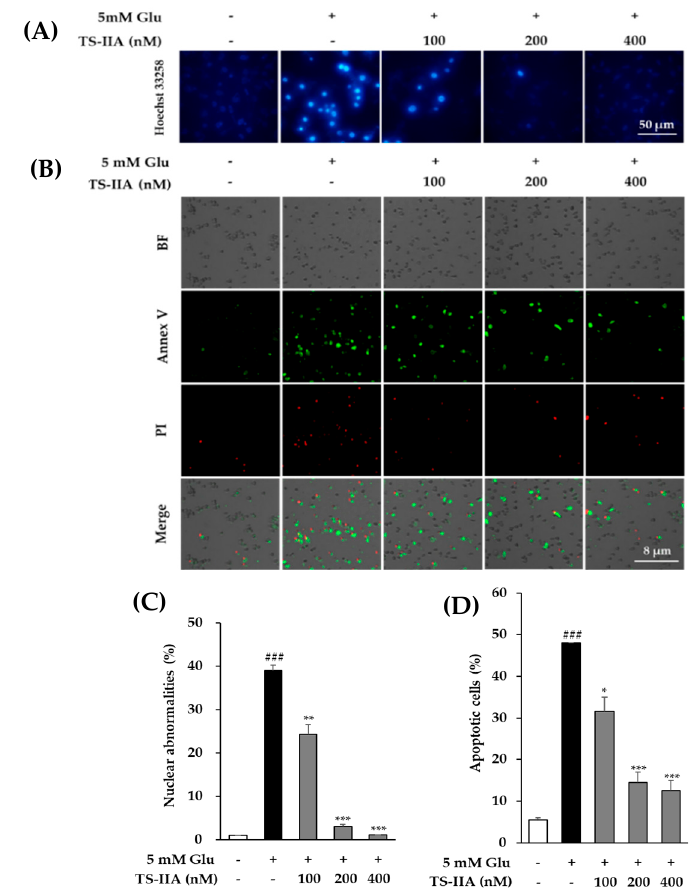
Figure 6. Protective e ff ect of tanshinone IIA (TS-IIA) against glutamate-induced apoptosis in HT-22 cells. ( A ) After treatment for 12 h with 100, 200, or 400 nM TS-IIA in the presence or absence of 5 mM glutamate, the chromatin of nucleus was stained with Hoechst 33,258 and observed by a fluorescent microscope (40 × ). ( B ) HT-22 cells were exposed to 100, 200, or 400 nM TS-IIA in the presence or absence of 5 mM glutamate for 12 h and dyed with PI and annexin V to visualize the dead and apoptotic cells using the Tali ® Image-Based Cytometer. ( C ) The percentage of nuclear abnormalities was calculated from the fluorescence images using ImageJ software ( N = 2). ( D ) The column graph depicts the proportion of cells undergoing apoptosis (annexin V-positive cells) quantified from the obtained images using TaliPCApp software ( N = 2). Notes: ### p < 0.001 compared with the untreated group, * p < 0.05, ** p < 0.01, and *** p < 0.001 compared with the glutamate-treated group. (TS-IIA: tanshinone IIA, Glu: glutamate).